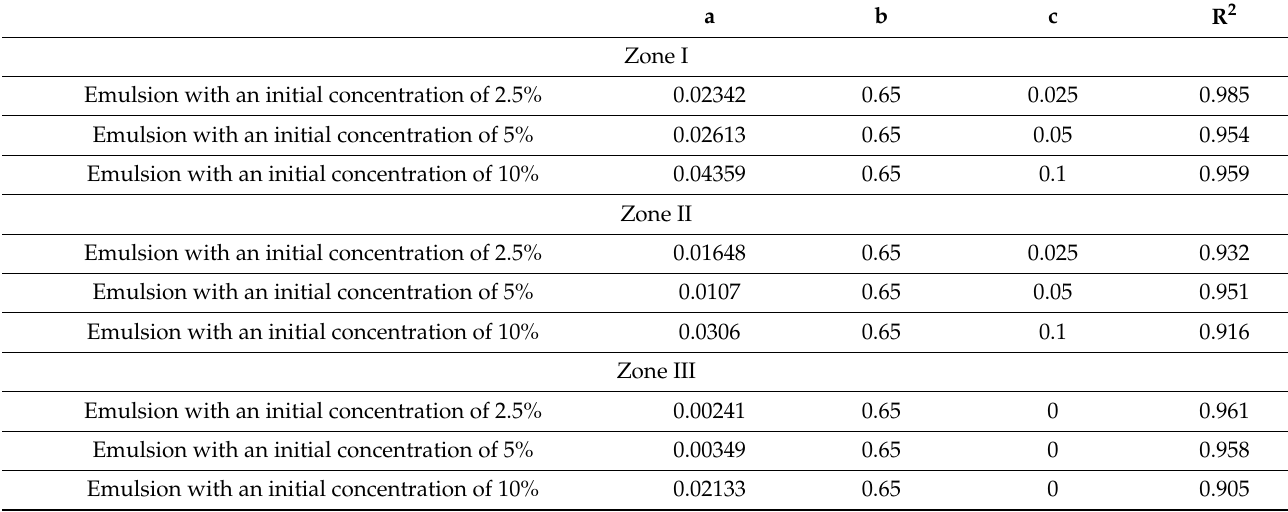
Table 2. Summary of the parameters in Equation (2) for the three emulsion flow